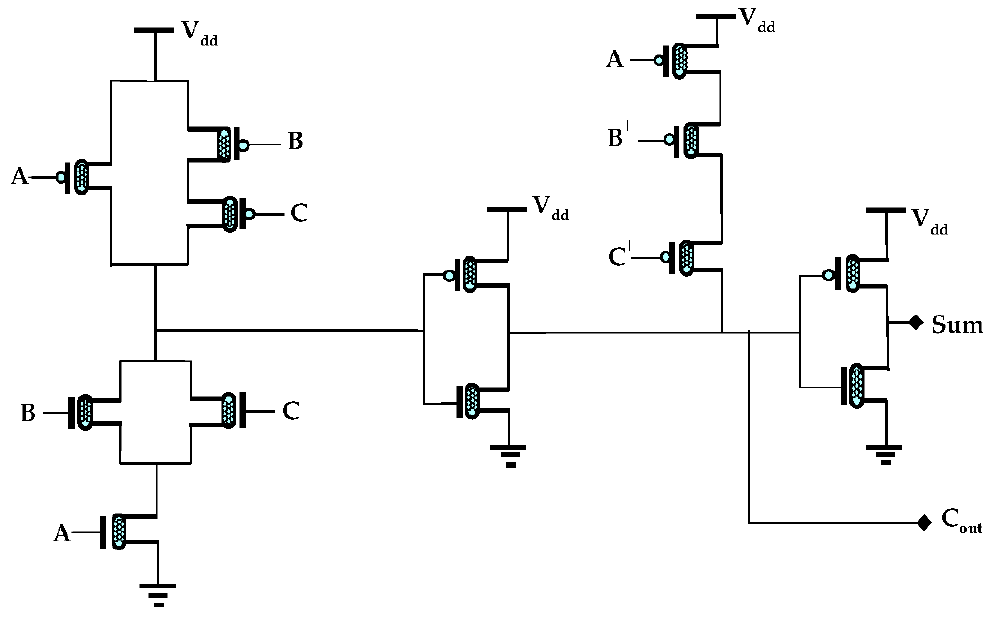
Figure 7. Proposed 13T AA design. Table 4. Proposed 13T AA truth table.